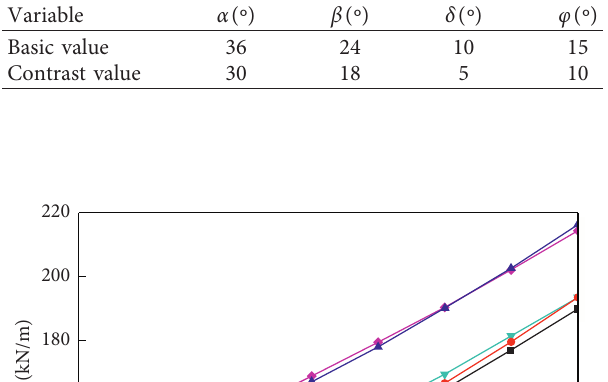
a with the involved